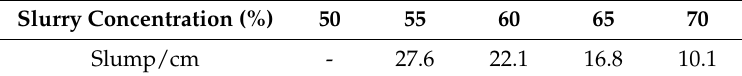
Table 4. Slump of different slurry concentration.